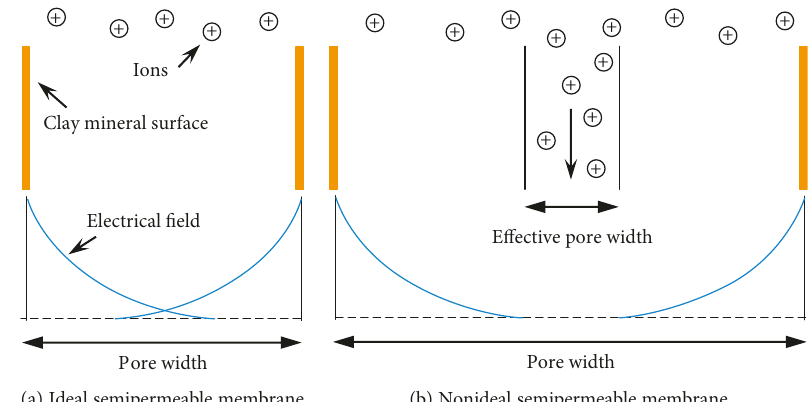
Figure 1: Clay as semipermeable